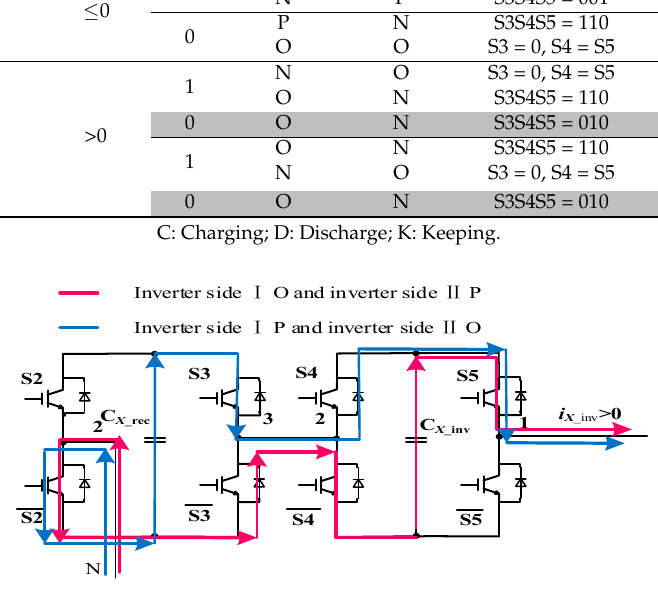
Figure 7. The discharging and keeping paths of capacitor C X _inv .